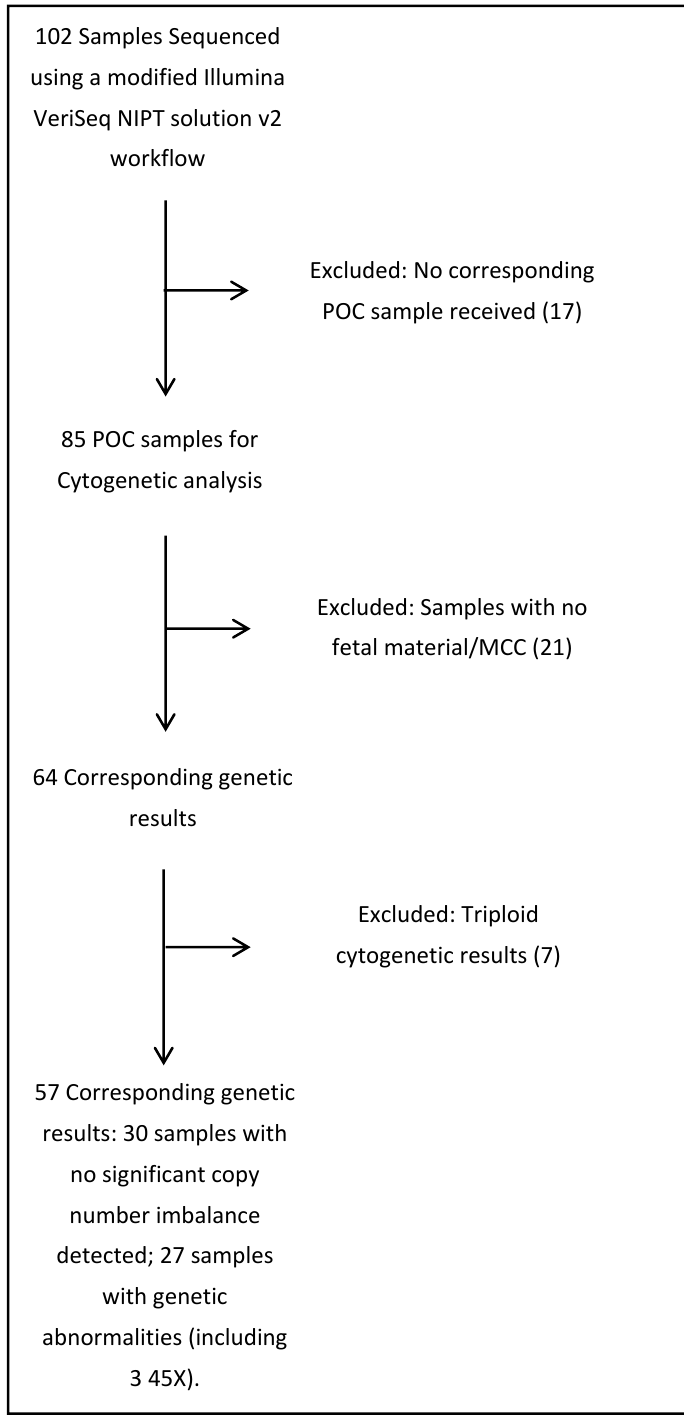
Figure 1. Flow chart describing inclusion/exclusion of cfDNA samples. MCC: maternal cell contamination; NIPT: on-invasive prenatal testing; POC: products of conception. Chromosomal abnormalities were identified by POC analysis in 27/57 (47%) cases. Patient